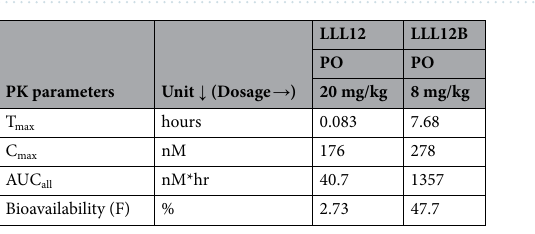
Table 1. Relative bioavailability of LLL12 and LLL12B in mice dosed PO. per os (PO): by mouth or orally.